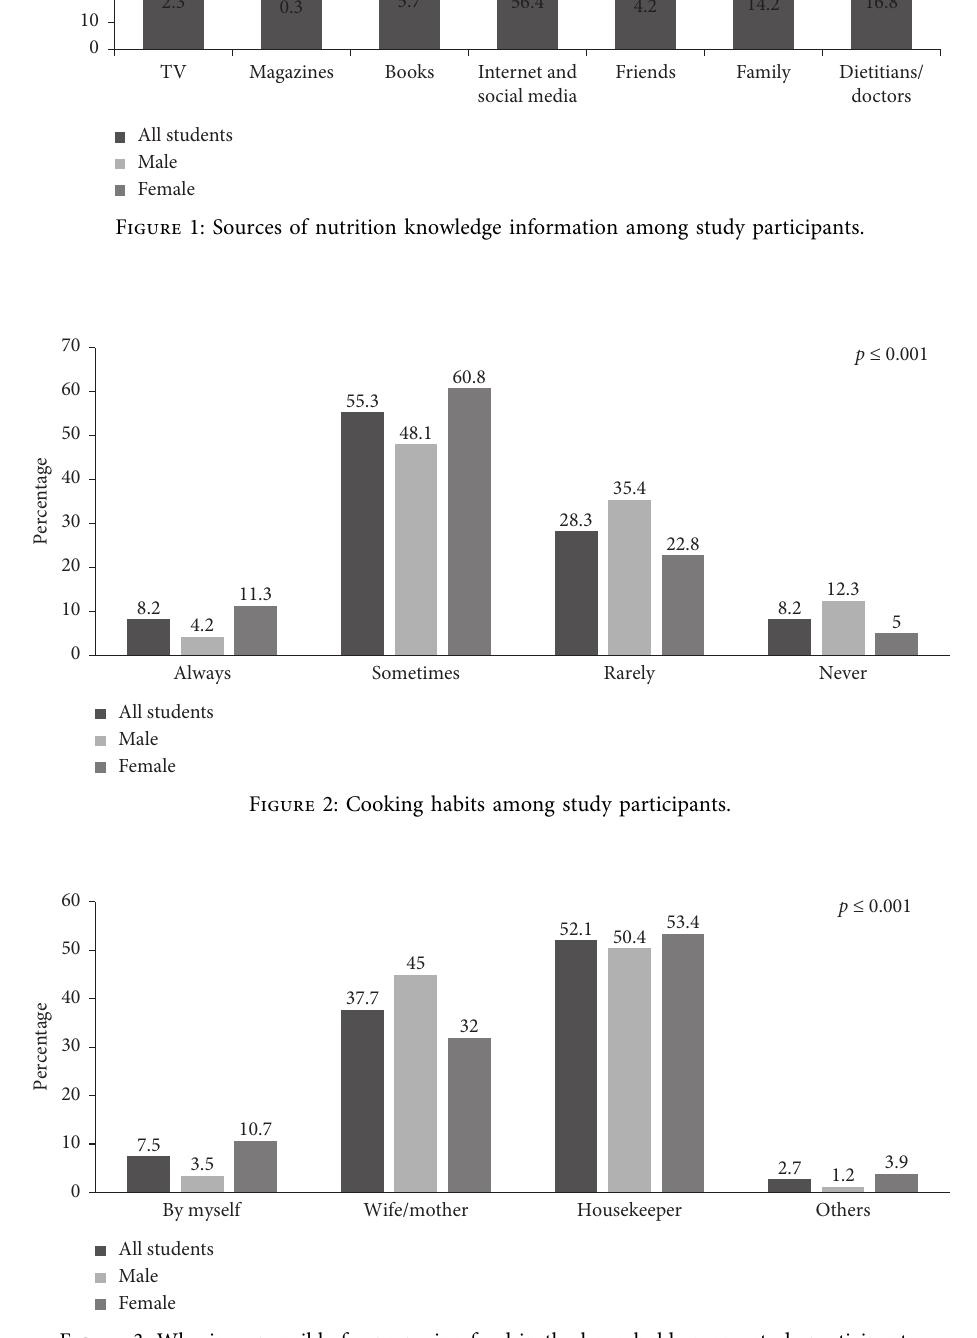
Figure 3: Who is responsible for preparing food in the household among study